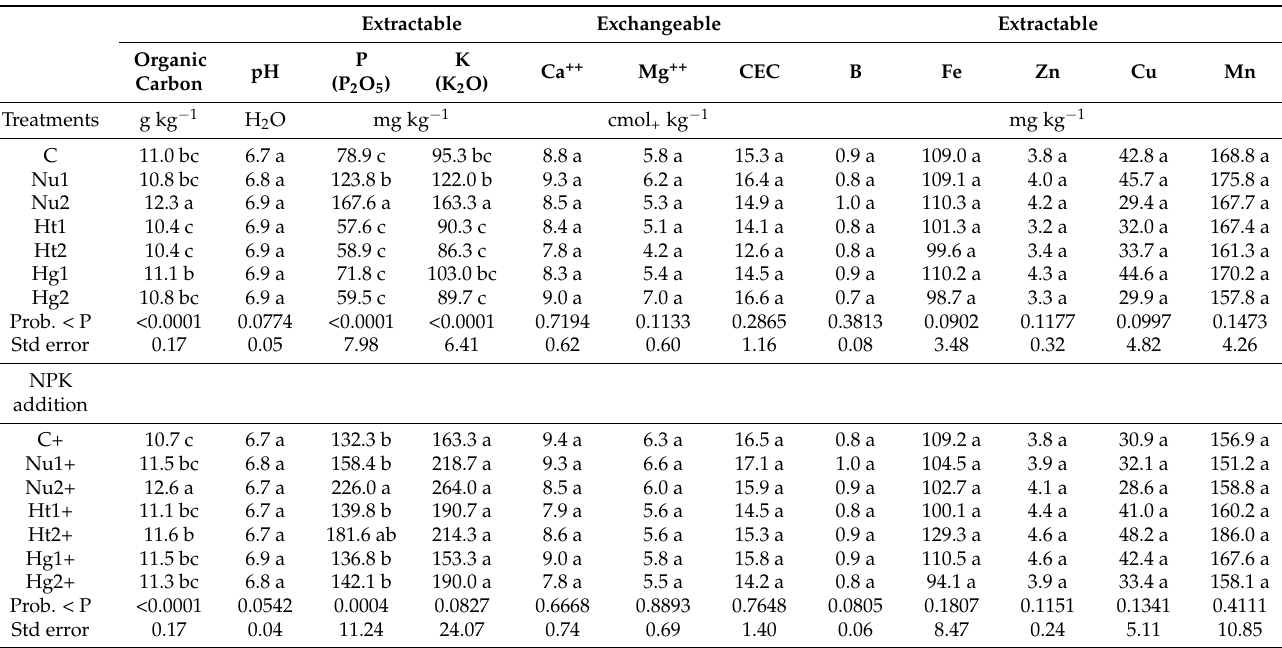
Table 5. Selected soil properties in response to the application of organic amendments (C, Control; Nu, Nutrimais; Ht, Humitec; and Hg, Humic gold, applied at two rates (1,2)), in experiments without and with NPK(+) mineral fertilization. For each independent experiment, means followed by the same letter are not significantly different by Tukey HSD test ( α =